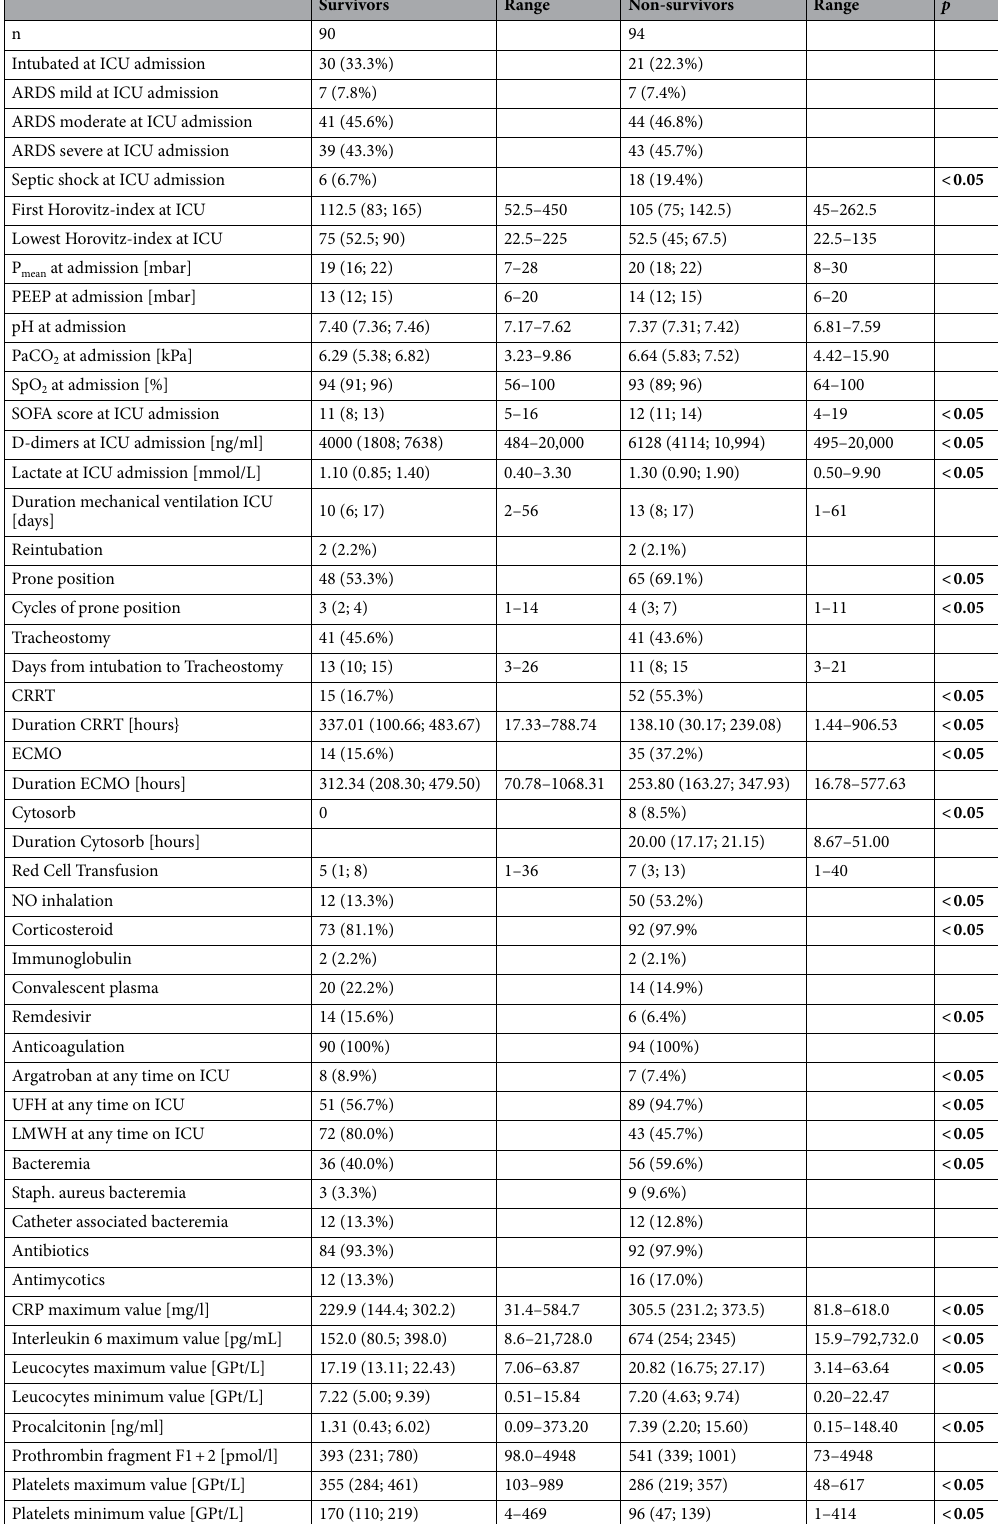
Table 5. ICU characteristics survival. Data are median (Interquartile range) or n (%). Significant values are in [bold]. ICU Intensive care unit, ARDS Acute respiratory distress syndrome, P mean Mean pressure, PEEP